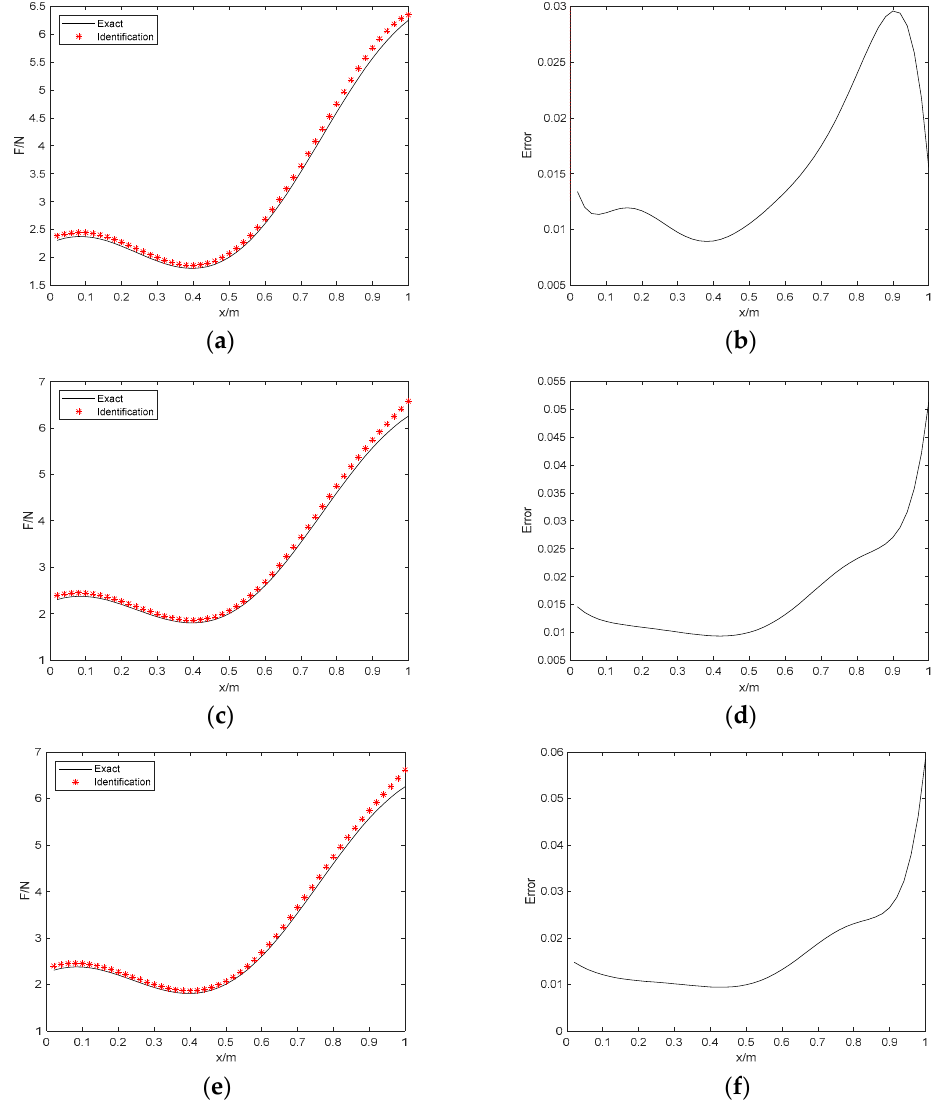
Figure 5. The identification results with 10% noise. ( a ) Proposed method; ( b ) identification error; ( c ) Tikhonov with L − curve regularization; ( d ) identification error; ( e ) Tikhonov with GCV regulariza- tion; ( f ) identification error.